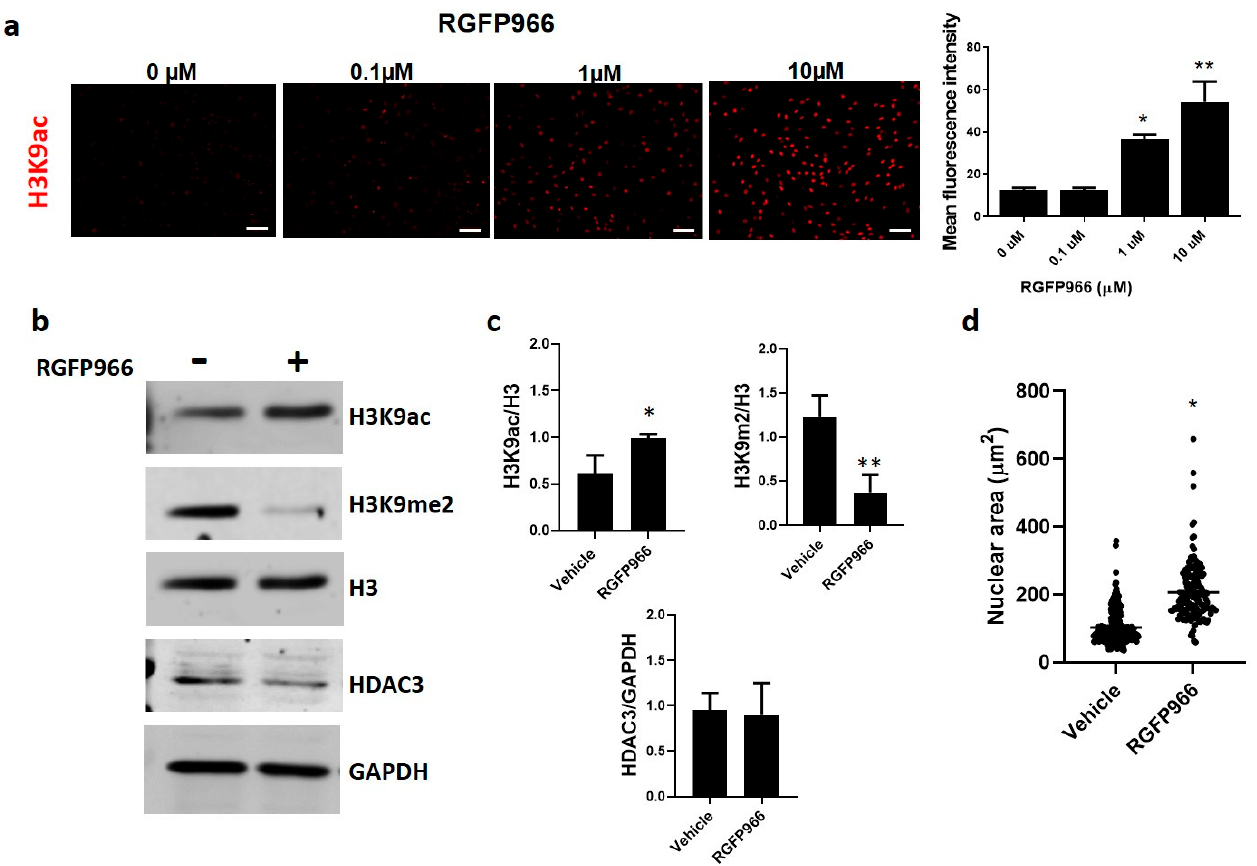
Figure 3. Pharmacological inhibition of HDAC3 by RGFP966 favors H3K9 acetylation, decreases H3K9 methylation, and increases nuclear area. ( a ) H3K9 acetylation of control fibroblasts treated with different concentrations of RGFP966 for 24 h; scale bar 100 µ m. The graph represents the quantification of fluorescence intensity; each bar represents mean ± SD from three independent experiments. ( b ) Representative immunoblot of H3K9ac, H3K9me2, and HDAC3 from fibroblasts treated with RGFP966 10 µ M for 24 h. H3 and GAPDH were used as loading controls. ( c ) Densitometric analysis of immunoblots from three independent experiments. ( d ) A measure of nuclear-projected area upon control and treated cells (RGFP966 10 µ M); data are given as mean ± SD from three independent experiments. * p < 0.05; ** p < 0.01 by Student’s t -test.